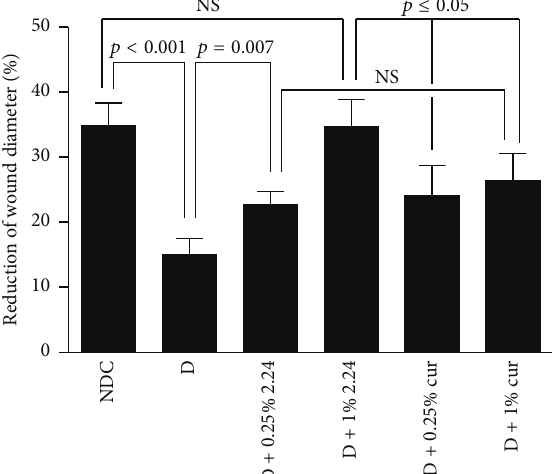
Figure 2: Healing, assessed clinically (% reduction in wound diameter), of skin wounds in normal (NDC) and diabetic (D) rats treated topically with vehicle alone or with 1% or 3% CMC2.24 or systemically with 30 mg/kg CMC2.24. Each value represents the mean ± SEM for 18 measurements (6 wounds per rat) per experimental group ( 𝑛 = 3 rats/group). NS: not statistically significant ( 𝑝 ≥ 0.05 ).